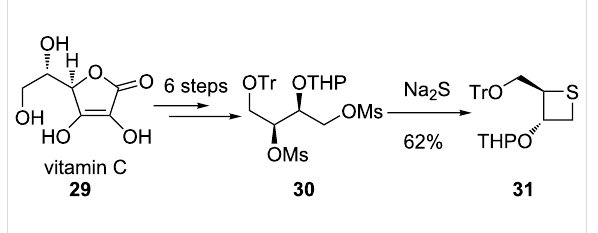
Scheme 6: Synthesis of optically active thietane 31 from vitamin